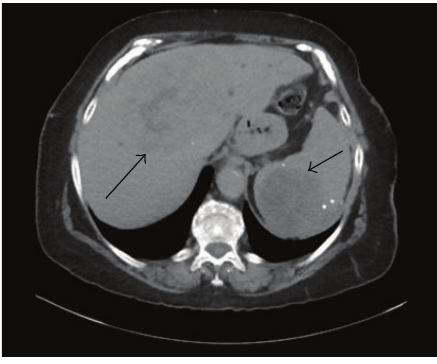
Figure 4: Case 2—CT scan abdomen pelvis with infiltrating ill- defined liver mass involving the portal confluence and spleen mass (black arrows).